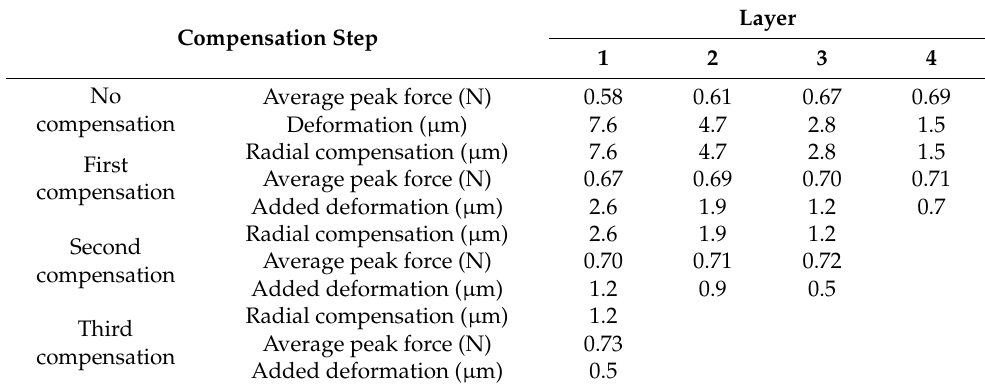
Table 4. The simulation results for the thin wall of 80 µ m thickness.